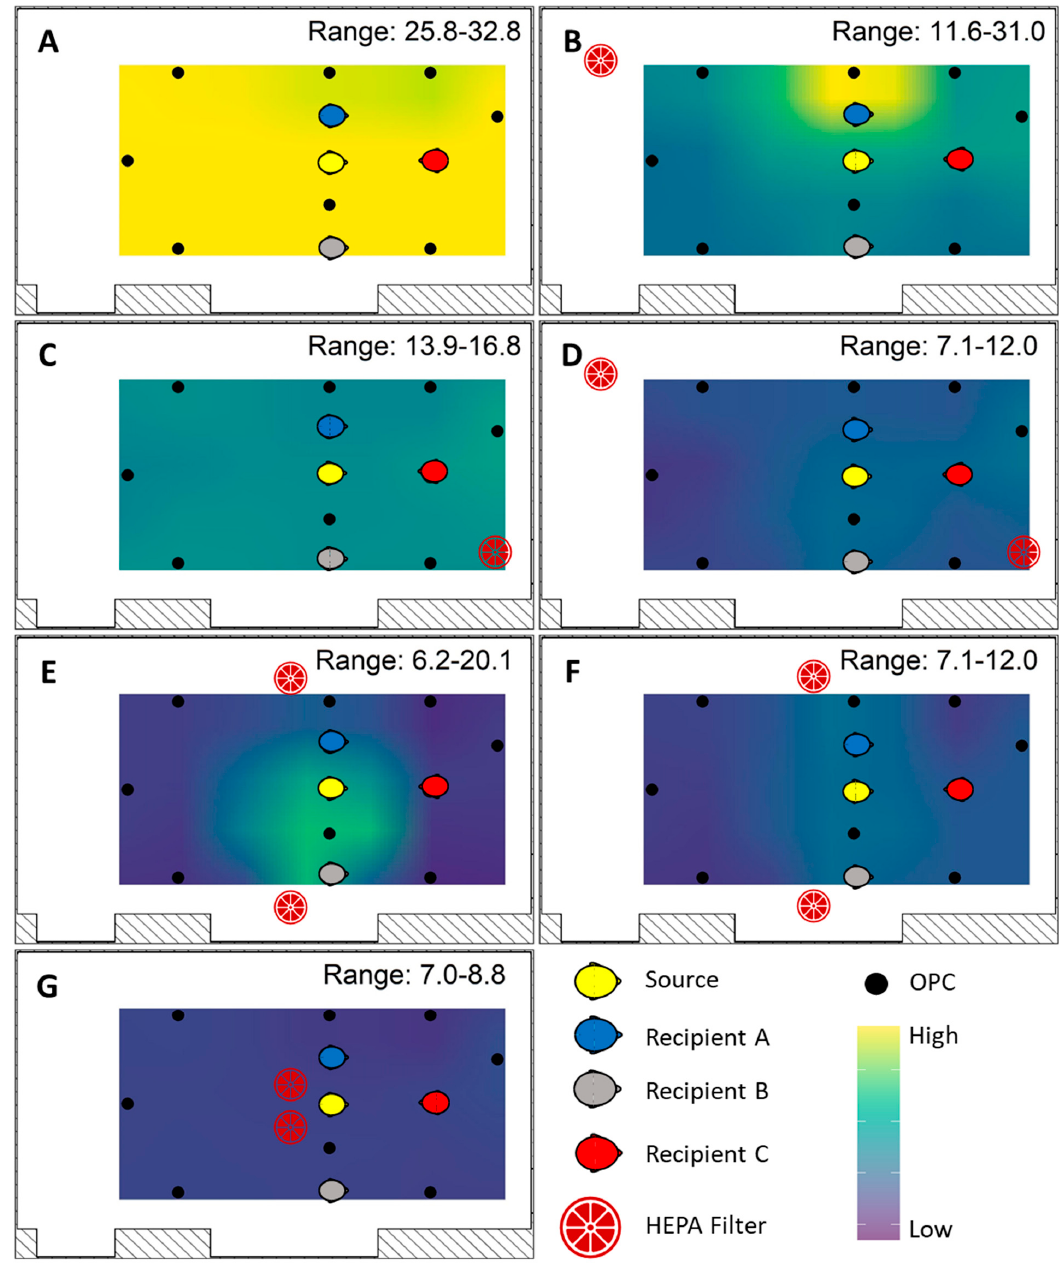
Figure 6. Spatial mean mass concentration distribution. The mean mass concentration of the area samplers was quantified and overlain on the HEPA configuration diagrams for the unmasked condition; analogous diagrams for the masked situation are included in Supplemental Figure S1. For each of the HVAC system ventilation and HEPA air cleaner configuration pairings, a separate geospatial map of the area samplers is presented: ( A ) HVAC system ventilation set at 2 ACH without HEPA augmentation; ( B ) one HEPA air cleaner placed in the back; ( C ) one HEPA air cleaner placed in the front; ( D ) two HEPA air cleaners placed in the front and back; ( E ) two HEPA air cleaners placed at the sides; ( F ) two HEPA air cleaners placed at the sides and raised upon 0.8 m tables; and ( G ) two HEPA air cleaners placed in the center of the room behind the aerosol source. Mean mass concentrations are the mean of four independent experiments. The coloration has been normalized to the concentration range observed among all trials, denoting purple as the lowest area sampler concentration and yellow as the highest. The relative spatial distributions of aerosols measured by area sampling were similar between unmasked and universal masking conditions, indicating that the room was well-mixed.